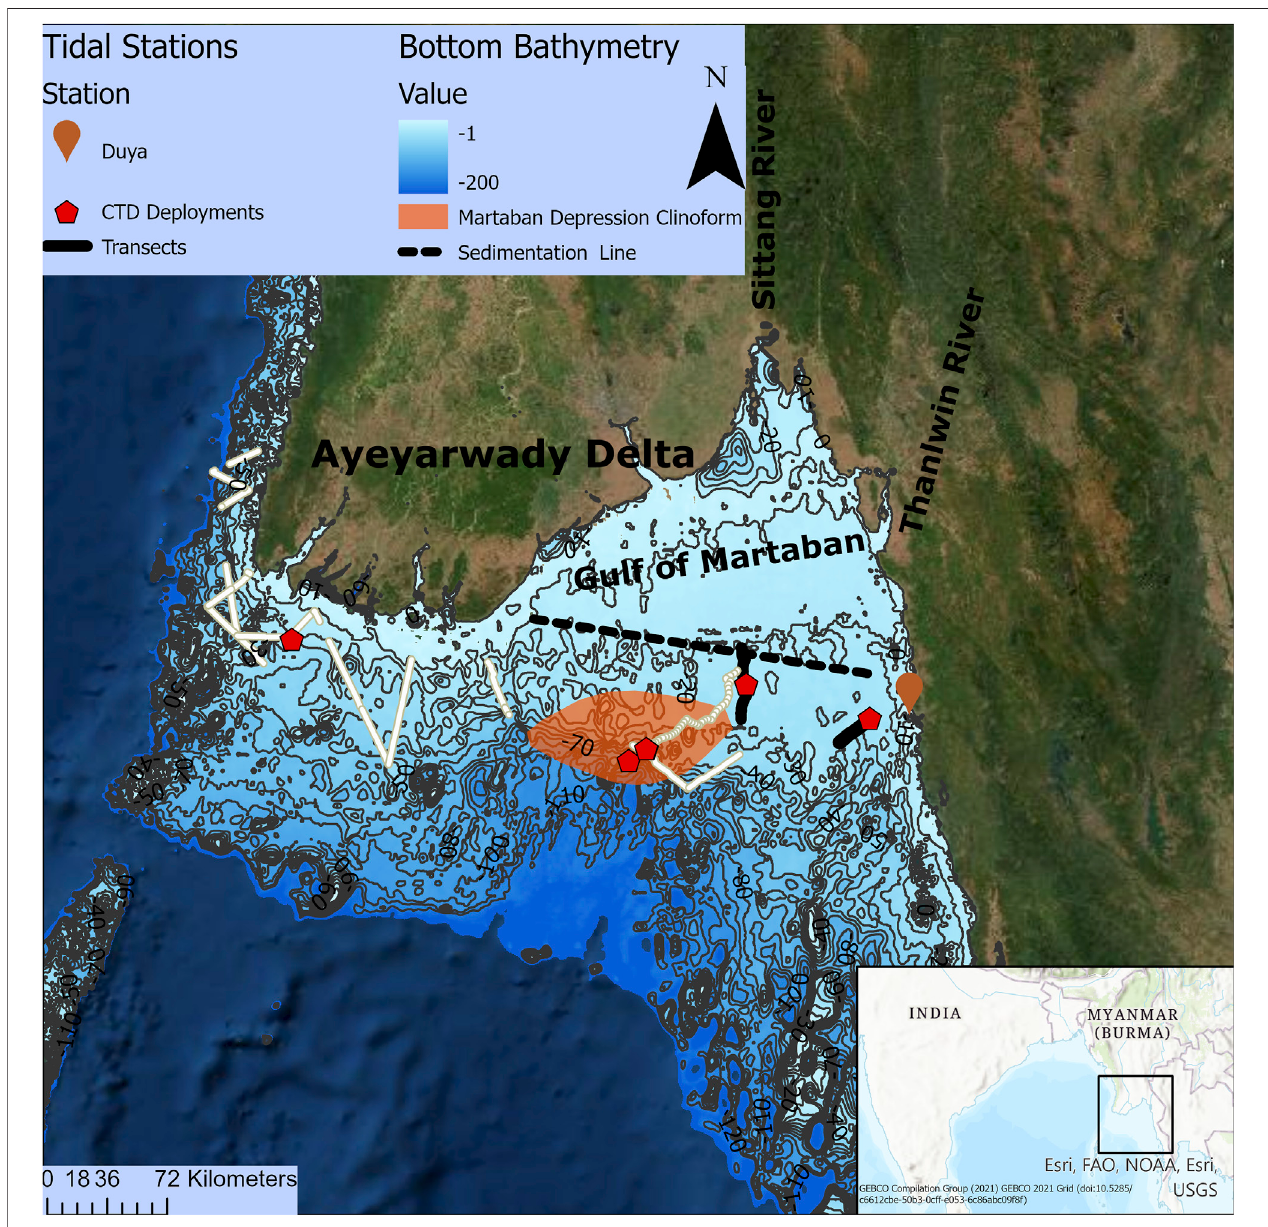
FIGURE1| MapofstudyareainthenorthernAndamanSea(seeinsetforlocationwithinIndianOcean).BlackandwhitelinesshowlocationsofallADCPtransects. This manuscript focused on the eastern-most ADCP Transects #5 and #21, shown as black lines. Red markers show locations of CTD-Tu samples. Orange marker shows location of Duya, Myanmar. The dotted black line demarcates areas identi fi ed as the mud blanket to the north; and a zone of accumulation to the south (Flynn et al., in press). The orange area in the zone of accumulation represents the location of the Martaban Depresssion Clinoform (Kuehl et al., 2019; Liu et al., 2020).